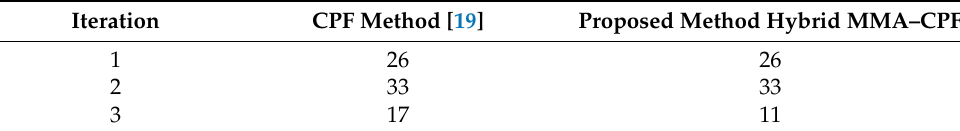
Figure 12. Losses comparison. Table 3. DER locations. Table 3. DER locations.